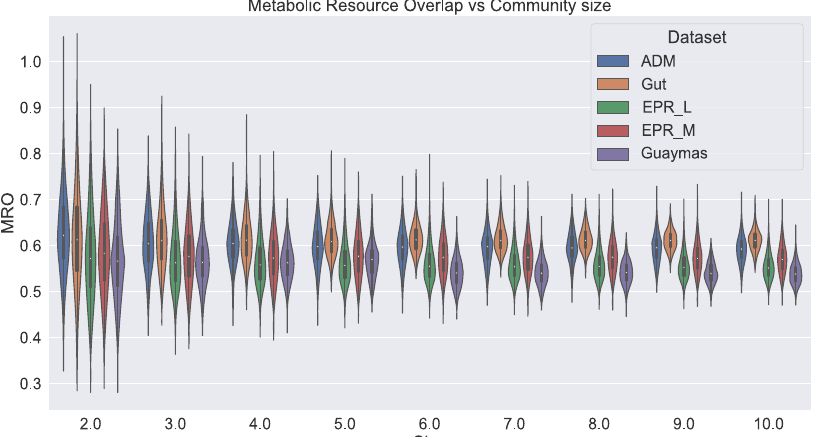
Fig. 7 Metabolic Resource Overlap scores of different microbiomes compared to the Guaymas microbiome. This violin plot represents the distribution of the MRO score of four different microbial communities. 1. Anaerobic Digestion Microbiome (ADM) (Blue) 2. Gut microbiome (Orange) 3. East Paci fi c Rise (EPR) L hydrothermal vent (active vent) microbiome (Green) 4. East Paci fi c Rise (EPR) M hydrothermal vent (inactive vent) microbiome (Red) 5. Guaymas microbiome (Violet). The MRO scores (Y-axis) are determined for different community sizes (X-axis), from a 2-member community to a 10-member